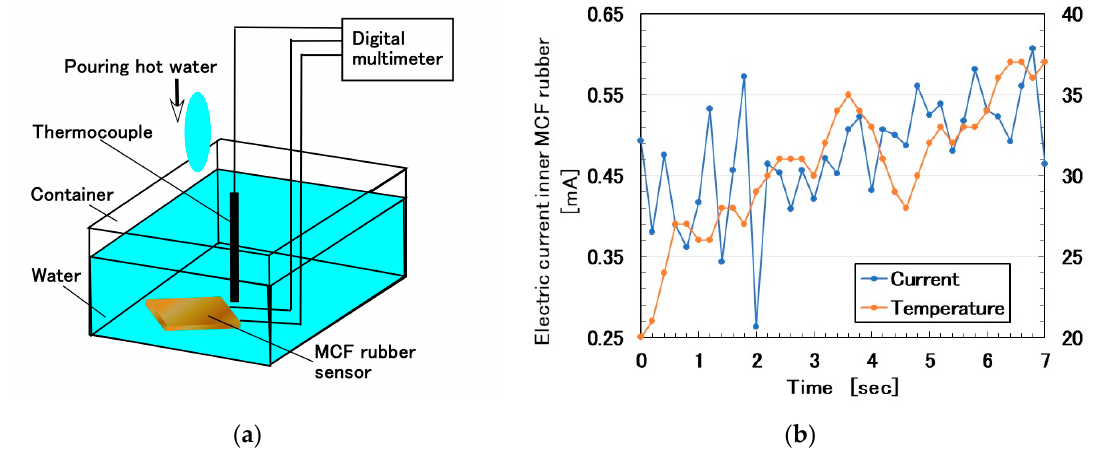
Figure 22. Temperature sensing of the MCF rubber sensor: ( a ) schematic diagram of experimental apparatus; ( b ) electric current of the MCF rubber sensor to the enhancement of temperature.